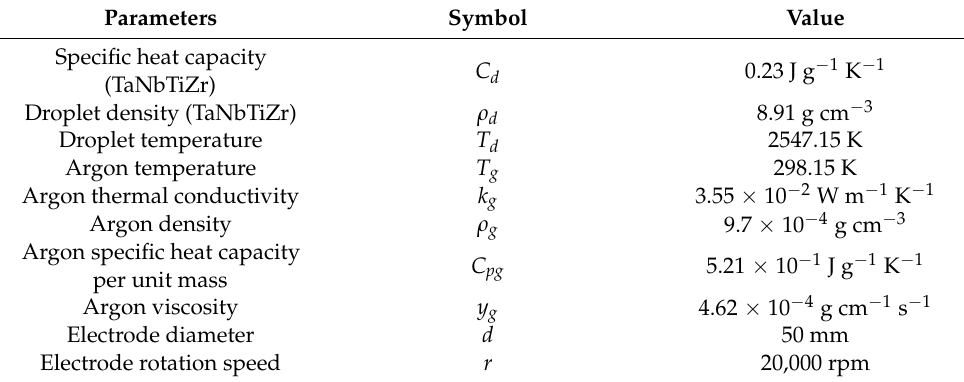
Table 3. The thermophysical parameters of the TaNbTiZr RHEA and argon, and the corresponding preparation parameters